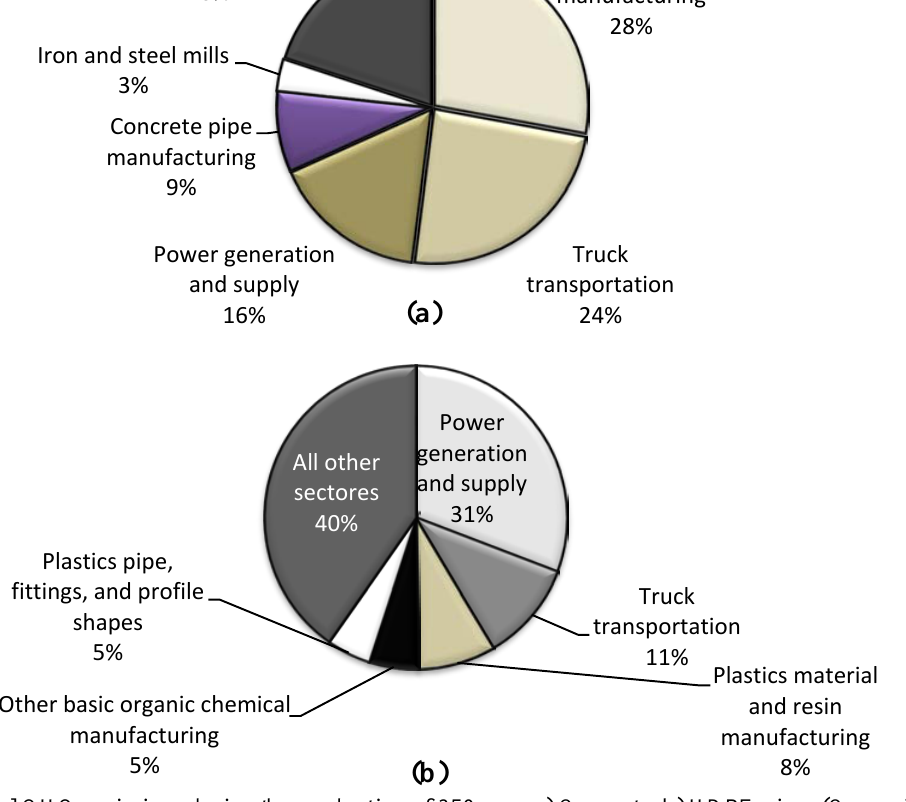
Fig. 3. Sectorial GHG emissions during the production of 350 mm; a) Concrete; b) HDPE pipes (Carnegie